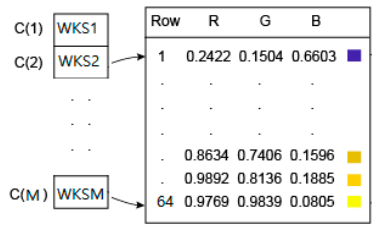
Figure 6. The relationship between the colormap and M vertices.